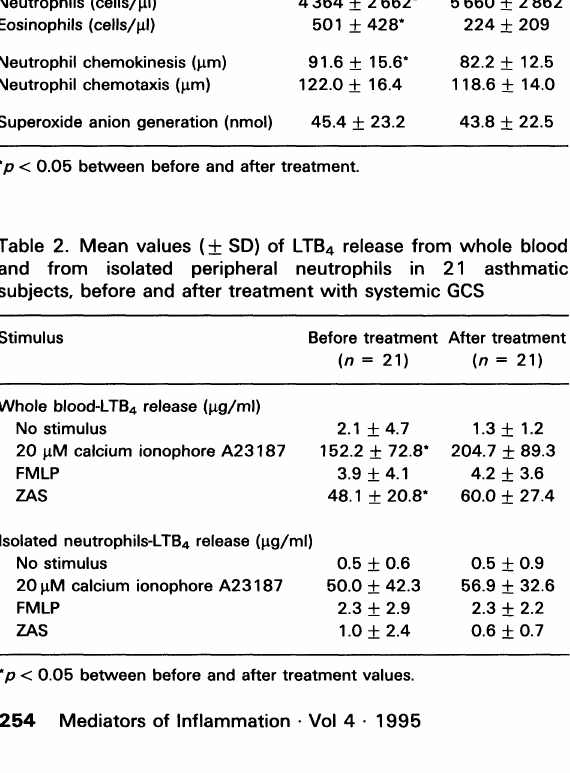
Table 1. Mean values (+ SD) of pulmonary function tests, blood cell count, migratory activity and superoxide anion generation of peripheral isolated neutrophils in 21 asthmatic subjects, before and after treatment with systemic GCS Parameter Before treatment After treatment (n 21) FVC (%pred)